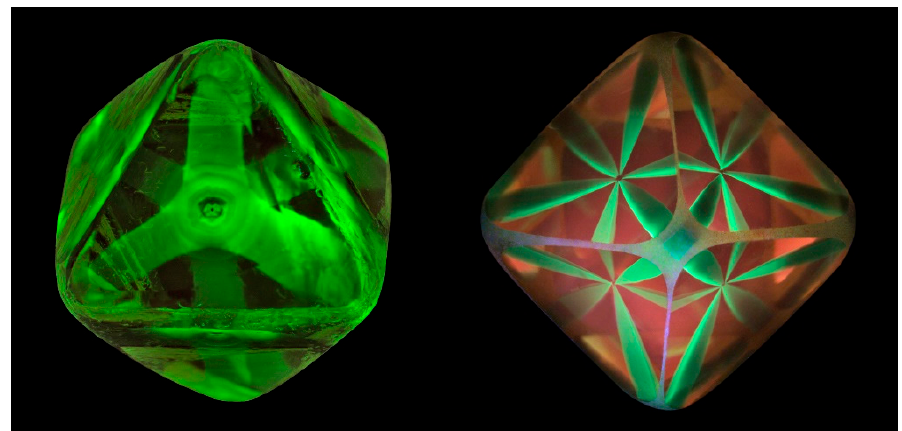
Figure 27. The fluorescence under 340 nm of two asteriated diamonds, a 2.50 ct polished octahedron on the left and the 11.38 ct Rhodesian Star on the right. While the sample included in this study (TH 2.626) shows only the S3 center green PL of the cuboid sectors while the octahedral sectors were totally inert, these two samples show the same S3 center green PL while the octahedral sectors fluoresces faint pink in the smaller sample and distinctly orange red in the larger stone. The fluorescence seen in the near colorless octahedral sectors is caused by a combination of the N3 center with the 655 nm broad band PL. Photos: Dr. Thomas Hainschwang.